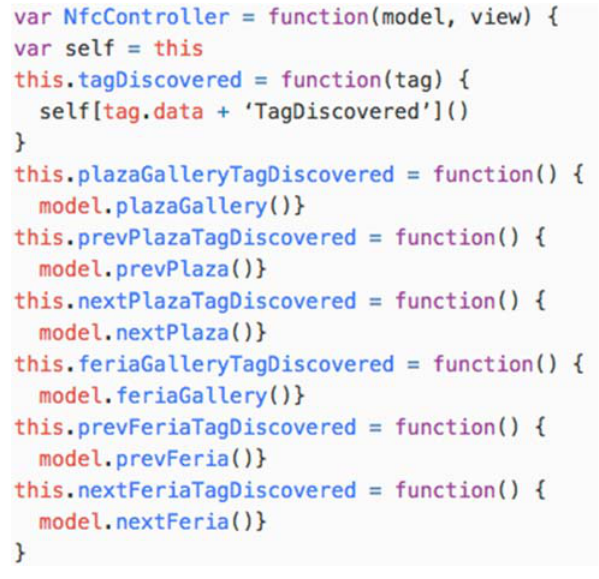
Figure 9. The nfc ‐ data ‐ controller.js JavaScript file. Figure 9. The nfc-data-controller.js JavaScript